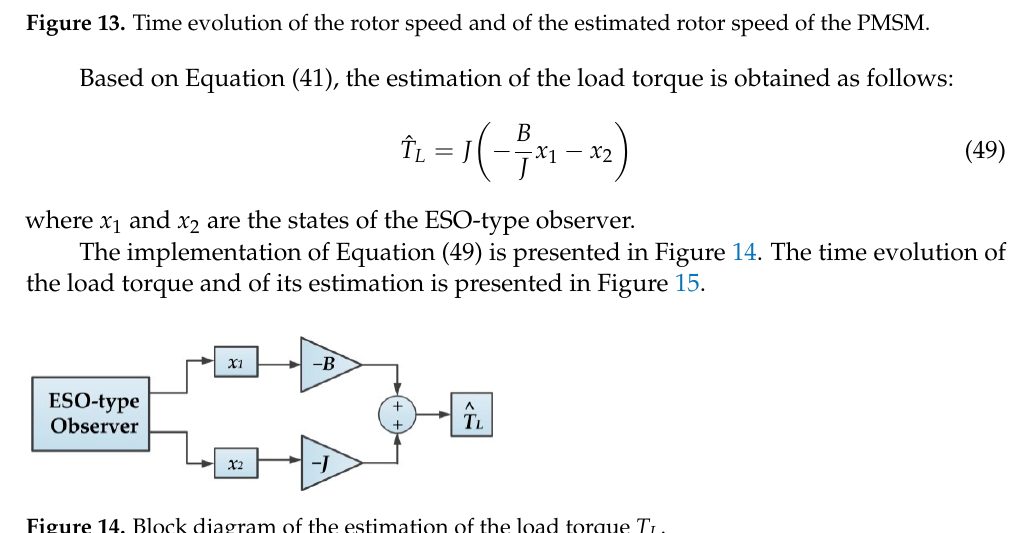
Figure 15. Time evolution of the load torque and of the estimated load torque T L .